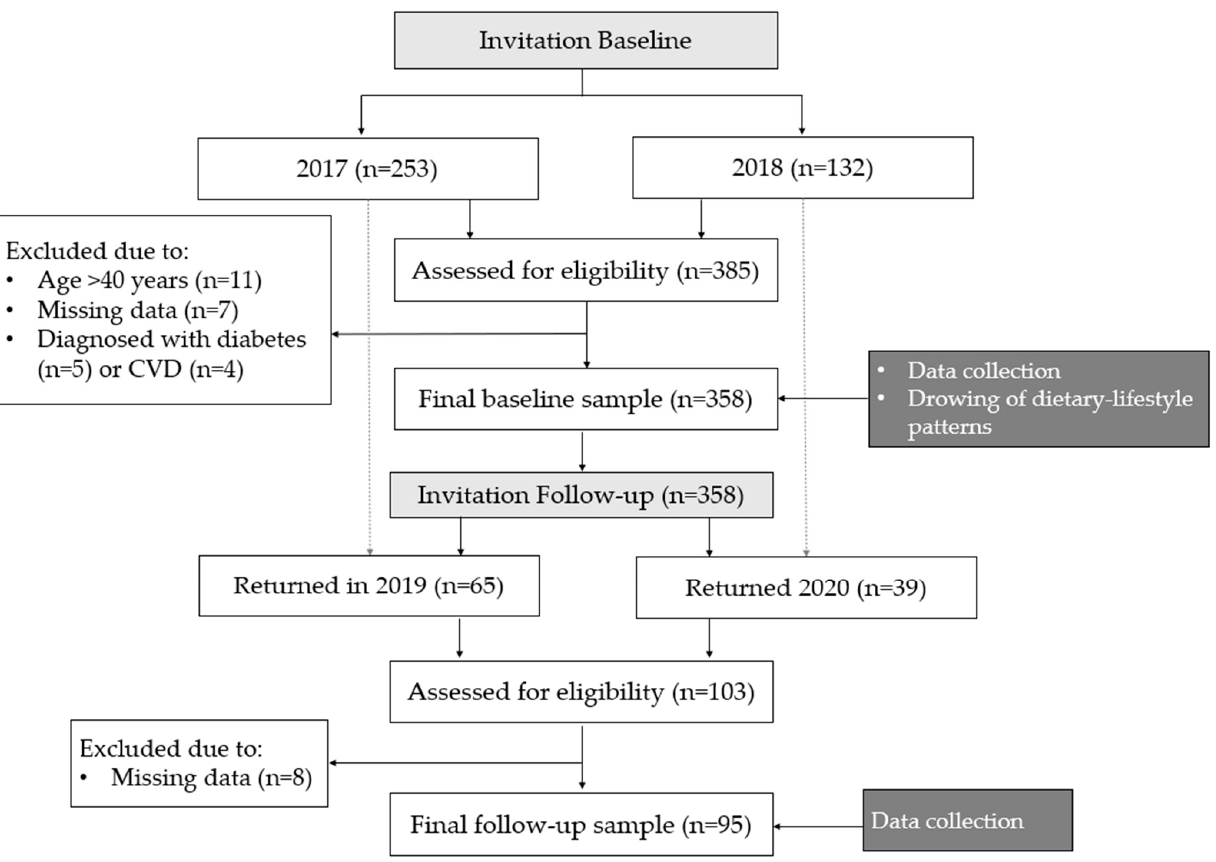
Figure 1. Study design and data collection.